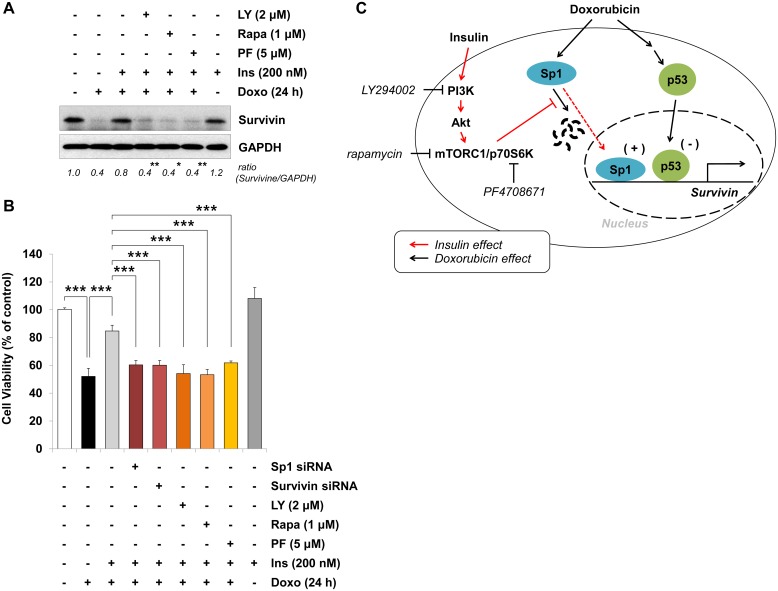
Survivin-mediated protective effect of insulin on the doxorubicin-induced cardiac cell death.After pretreatment with the indicated inhibitors for 1 h (A, B), or transfection with either survivin siRNA or Sp1 siRNA for 24 h (B), cells were left untreated or treated with insulin (Ins) for 1 h, followed by doxorubicin (Doxo) for 24 h. (A) Whole cell lysates were immunoblotted with anti-survivin antibodies. Numbers represent the mean ±S.D. of the normalized densitometric analyses of survivin protein levels (n = 4). (B) Cell viability was assessed by the MTT assay (n = 3 performed in triplicates). Values are mean ±S.D. (*p < 0.05; **p < 0.01; ***p < 0.001). (C) Schematic diagram of insulin-induced cardiac myocytes protection against doxorubicin toxicity. Pro-apoptotic signaling cascades induced by doxorubicin are shown as black lines and pro-survival (or anti-apoptotic) signaling pathways induced by insulin are shown as red lines. (+) indicates positive transcriptional regulator (e.g. activator); (-) indicates negative transcriptional regulator (e.g. repressor).